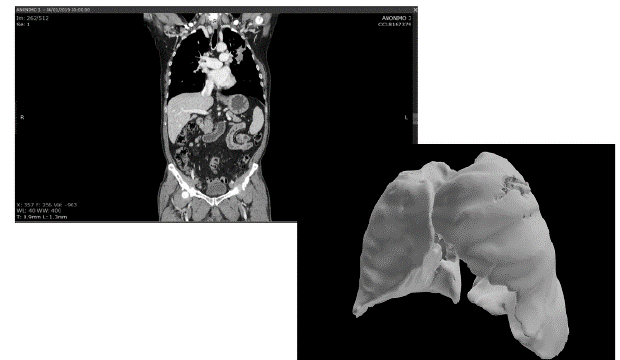
Figure 1. Example of CT scans (coronal section, above) and 3D hologram as seen by the research participants.